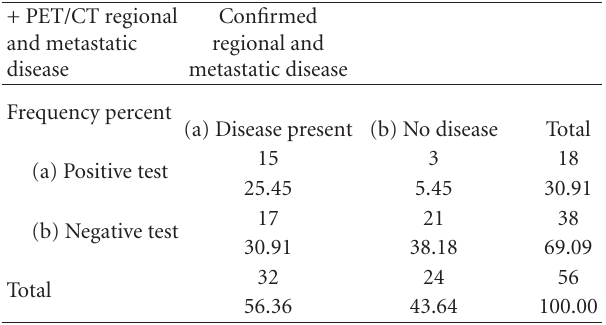
Table 6: 2 × 2 Table of PET/CT with combined regional and distant metastatic